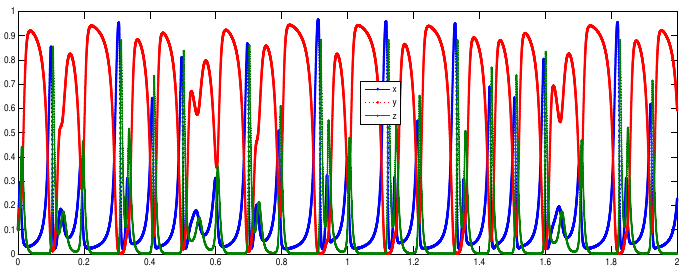
Figure 8. Time responses of system (4) with the parameters given in (18) and h = 0.05.